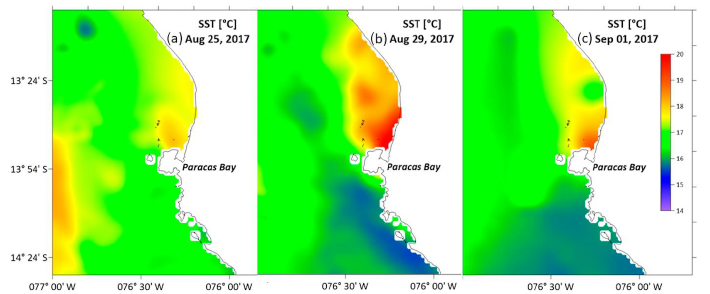
Figure 5. Sea surface temperature (SST) in Paracas Bay and environs; ( a ) 25 August 2017, ( b ) 30 August 2017 and ( c ) 1 September 2017 (GHRSST). 3.2. Morphology The strain isolated from Paracas Bay was coded and morphologically identified as Prorocentrum cordatum (Ostenfeld) J. D. Dodge, 1975. The cells of the strain IMP-BG 450 are between 13.8 and 17.2 µm long and 12.7 – 15.6 µm wide. The cells have round-oval shapes and a high frequency of pentagonal forms (Figure 6a,b), the posterior extreme of the valves is rounded to angled, and the anterior end is straight with a V-shaped central depression and an apical spine. The valves’ surfaces are covered with small, point y spines